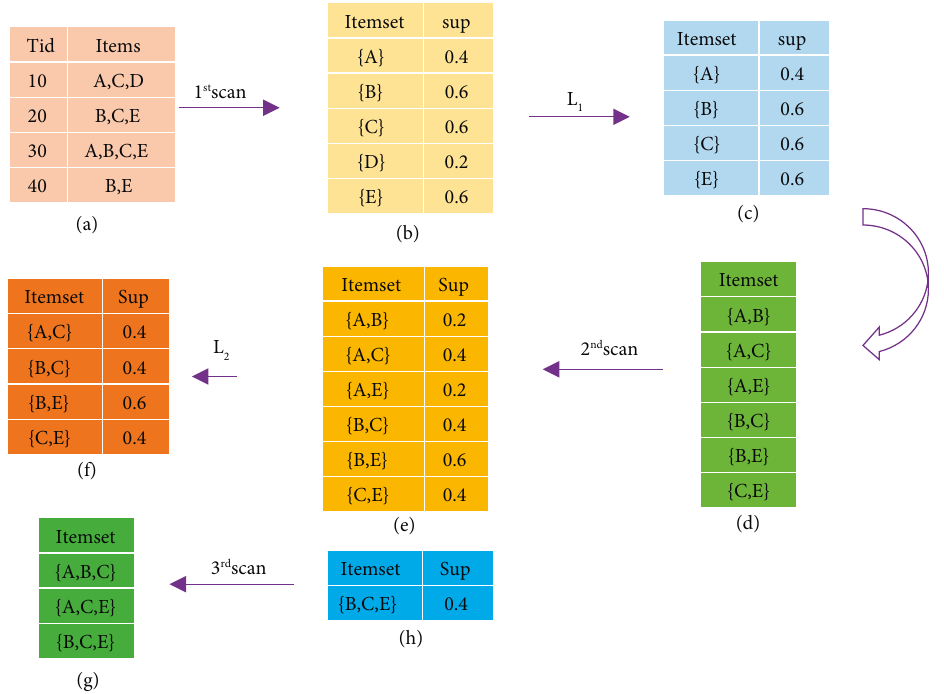
Figure 4: Example diagram of the mining process of the Apriori